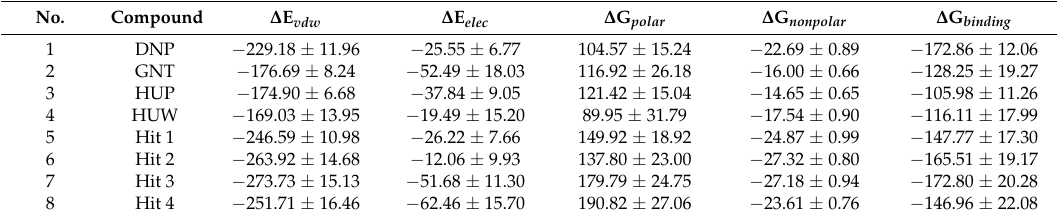
Figure 8. The number of hydrogen bonds between hAChE and hit compounds. Hydrogen bond interactions for each hit compound were monitored during10 ns simulation time. The number of hydrogen bonds for each hit compound are indicated as blue, green, magenta, and purple lines. Binding free energies between the compounds and hAChE were predicted using MM-PBSA method. Average binding free energies for reference compounds ranged from − 172.86 kJ/mol to − 105.98 kJ/mol (Table 4). Average values for hit compounds were − 147.77 kJ/mol, − 165.51 kJ/mol, − 172.80 kJ/mol, and − 146.96 kJ/mol for Hit 1, Hit 2, Hit 3, and Hit 4, respectively. Table 4. Binding free energy (kJ/mol) calculated by MM-PBSA method. Δ E elec , electrostatic energy; Δ E vdw , van der Waal energy; Δ G polar , polar solvation energy; Δ G nonpolar , nonpolar solvation energy; Δ G binding , binding energy.